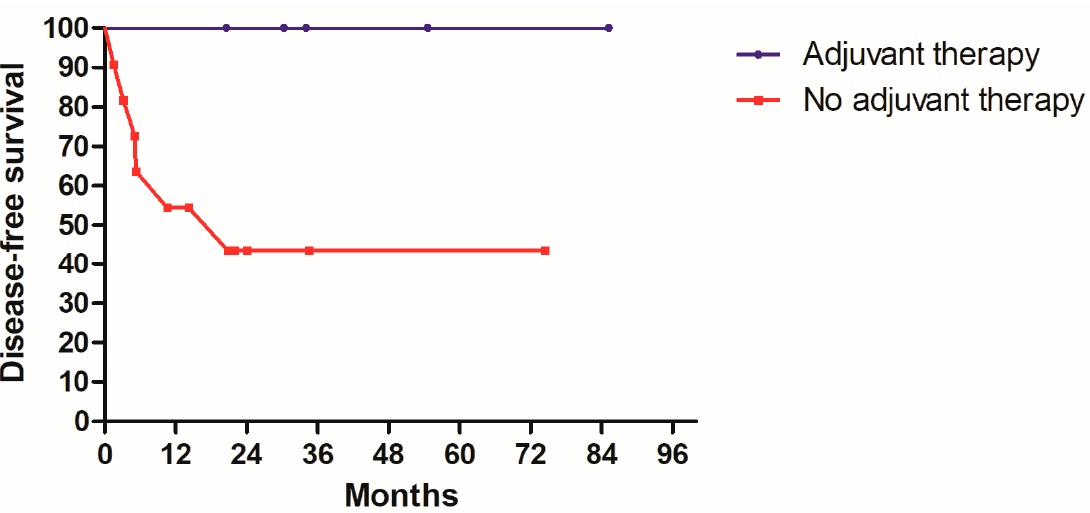
Figure 4. Kaplan–Meier disease-free survival curve according to adjuvant therapy status in 16 patients with only PNI positive.